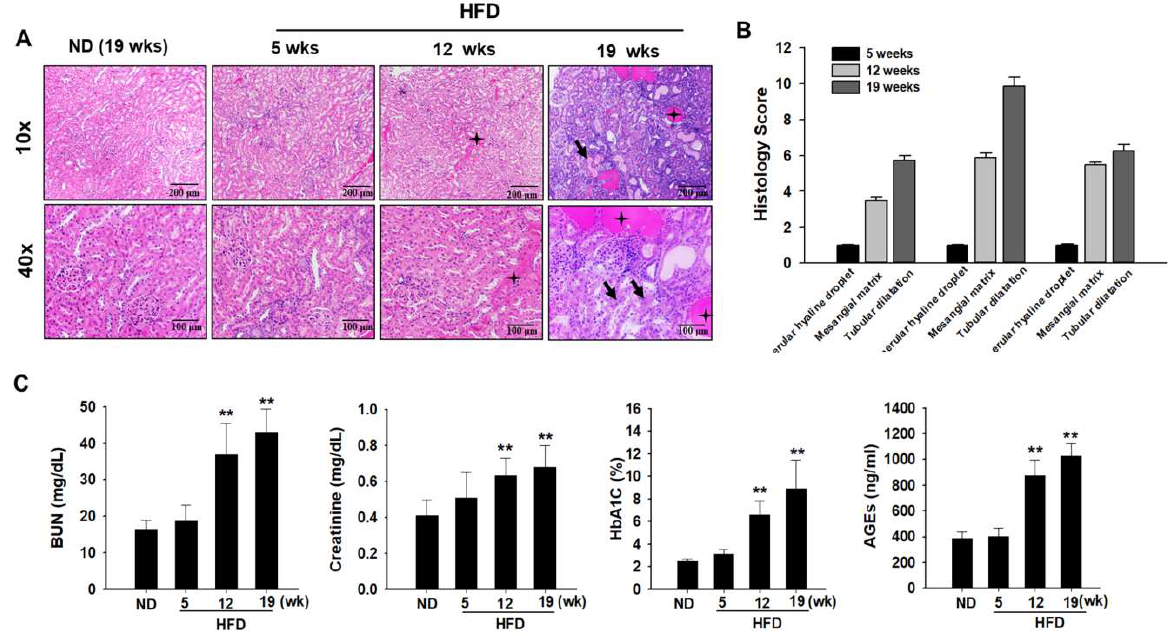
Figure 2. Effects of a high-fat diet (HFD) on biochemical parameter changes. Zucker diabetic fatty (ZDF) rats were divided into two groups: (1) the normal diet (ND) and (2) HFD groups. ( A ) Kidney samples were histologically examined. Renal histological abnormalities, including a hyaline cast of renal tubules, mesangial cell expansion, thickening of the basement membrane, increased mesan- gial matrix, formation of glomerular hyaline droplets (black stars), and tubular dilatation (black arrow), were observed in the kidney of diabetes-induced rats using hematoxylin and eosin (H&E) staining. ( B ) Histology scores for renal injury are as follows: 1, normal; 2, minimal; 3, slight; 4, moderate; 5, marked; and 6, severe at 5 weeks, 12 weeks, and 19 weeks in the kidneys of HFD-induced rats with DN. ( C ) Levels of blood urea nitrogen (BUN), serum creatinine (SCr), gly- cated hemoglobin (HbA1C), and advanced glycation end products (AGEs) in the blood serum were measured after fasting at the end of experiment. All abovementioned biochemical parameters were analyzed under 12 h fasting conditions. Data are expressed as the mean ± standard deviation of each group. ** p < 0.01. ND, normal diet; HFD, high-fat diet. 2.3. Urinary Biomarker Levels in HFD Rats Urinary excretion of microalbumin plays a key role in the detection of diabe- tes-induced renal injury [28,29]. We observed that the urinary albumin-to-creatinine ratio was significantly higher in HFD-induced diabetic rats than in ND-fed rats (Figure 3A). Protein levels in the urine significantly increased with progressing hyperglycemic con- ditions, accompanied by significant decreases in urinary Cr, which indicated a significant alternation in the kidney function of HFD model rats (Figure 3A). These results indicate the presence of kidney injury in HFD-induced diabetic rats, as determined by histo- pathological evaluation. Even so, albumin, protein, and Cr levels in the urine were not significantly increased after 5 weeks in HFD-induced rats. To compare the sensitivity of these urinary biomarkers, we also measured protein-based biomarkers, including PKM2, KIM-1, and NGAL, in rat urine. As shown in Figure 3B, PKM2 expression was higher in HFD-induced diabetic rats than in ND-fed rats after 5 weeks. These results were con- firmed using immunohistochemical (IHC) analysis, in which PKM2 and KIM-1 overex- pression was observed after 5 weeks in HFD-induced diabetic rats.